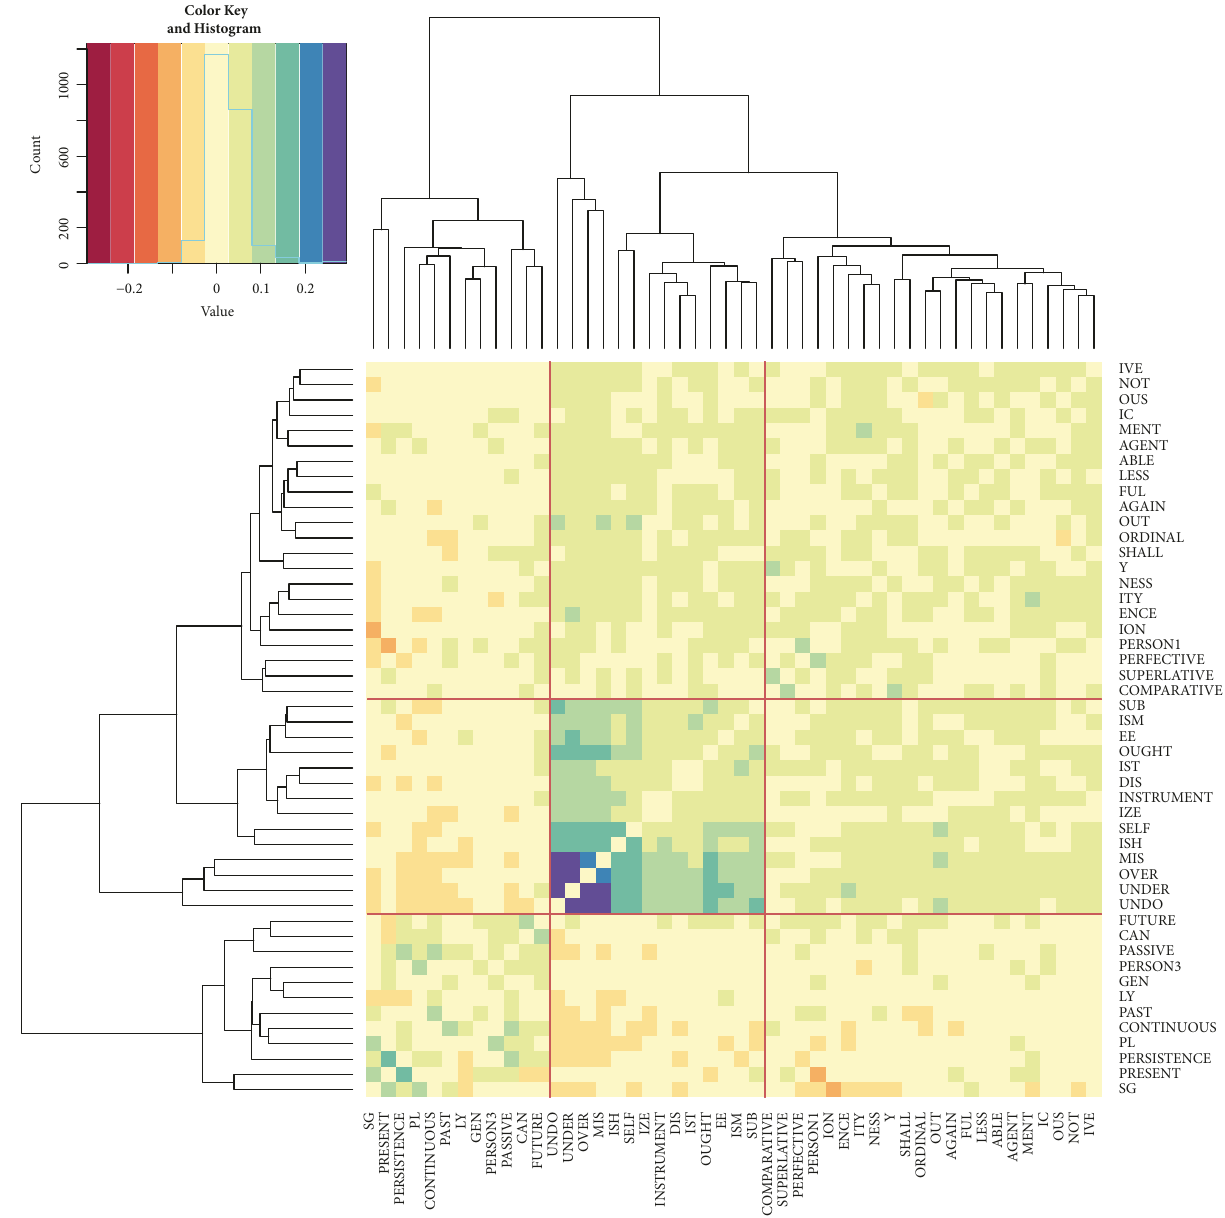
Figure 2: Heatmap for the correlation matrix of the row vectors in S of derivational and inflectional function lexomes (individual words will become legible by zooming in on the figure at maximal